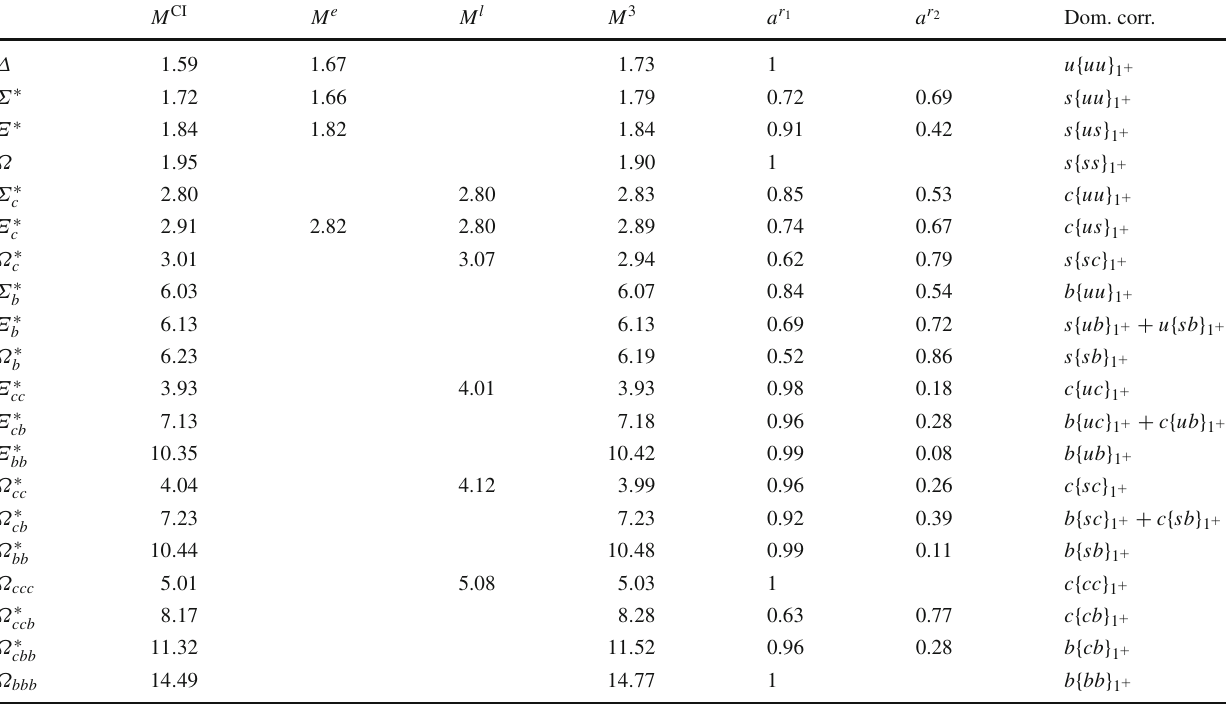
Table 6 Computed mass (in GeV) and Faddeev amplitude for each ground-state flavour- SU ( 5 ) J P = 3 / 2 − baryon: the last column iden- tifies the baryon’s dominant spin-flavour correlation. The possibilities are given in Eqs.(B.10), (B.12), (B.14), (B.16). Empirical mass values,